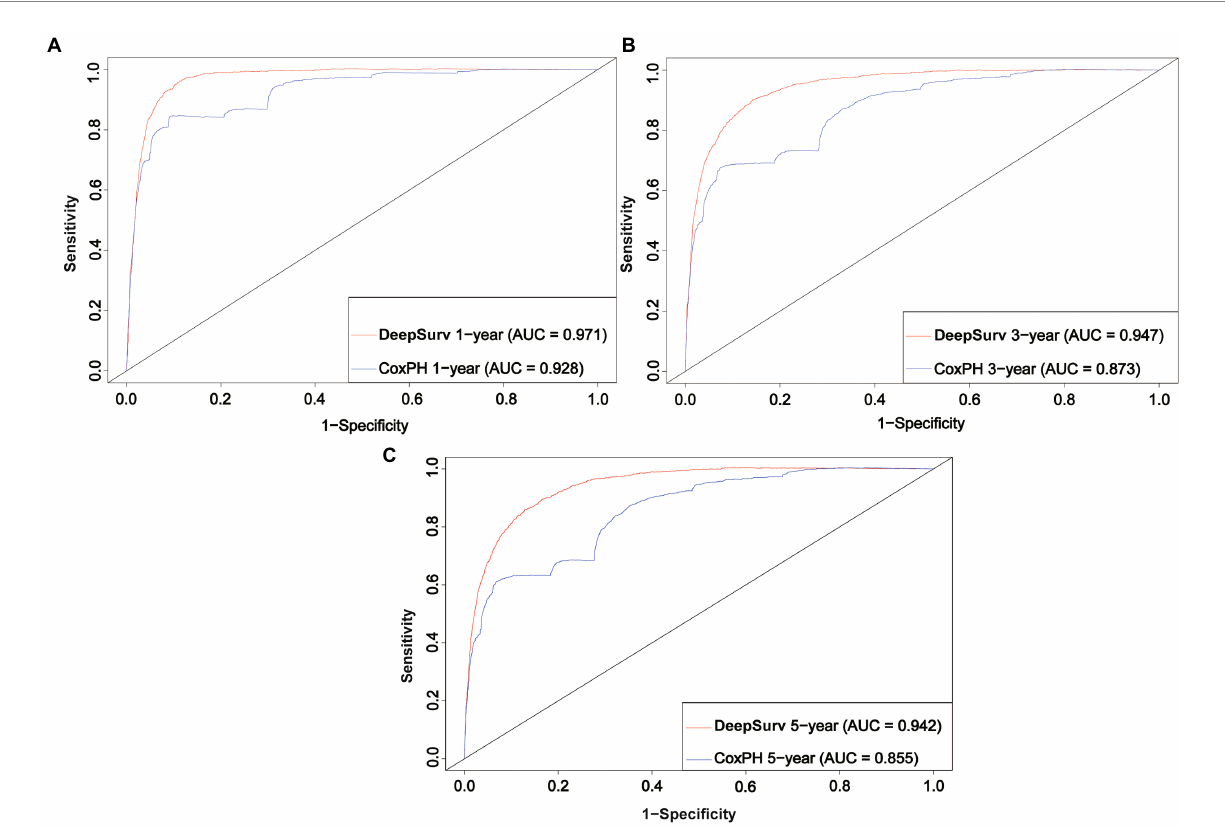
FIGURE 7 ROC curves. Comparison of ROC between the CoxPH model and the DeepSurv model in 1 year (A) , 3 year (B) , and 5 year (C)